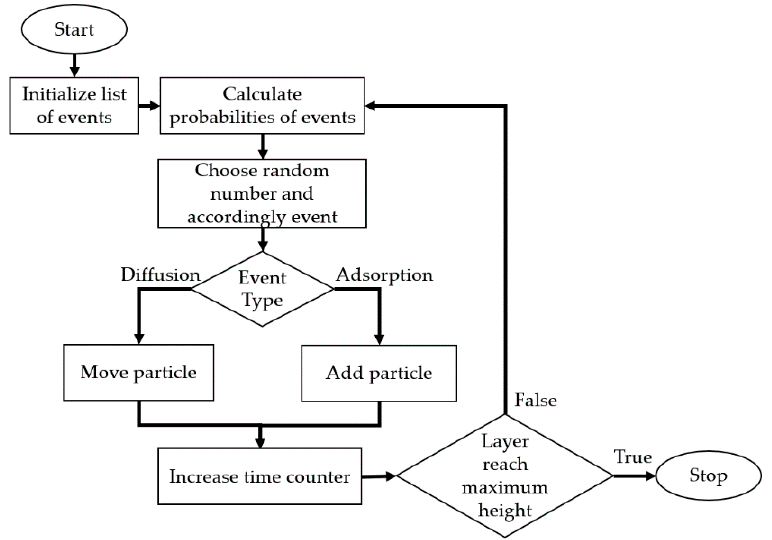
Figure 2. Block diagram showing the kMC algorithm of the PLD.